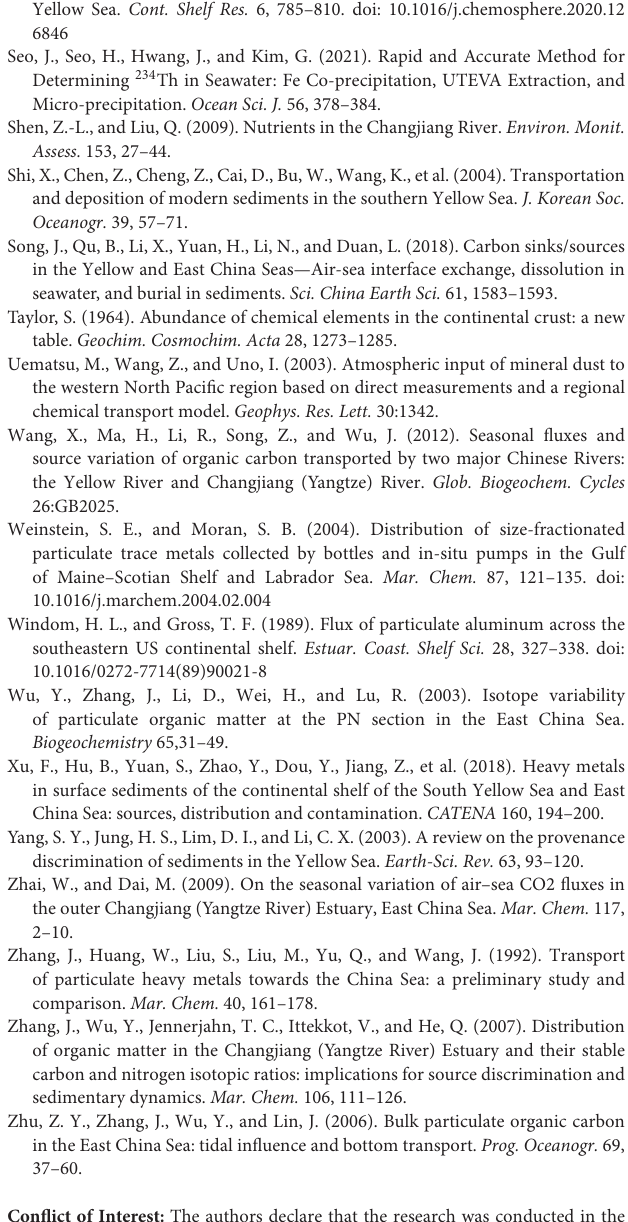
table. Geochim. Cosmochim. Acta 28, 1273–1285. Uematsu, M., Wang, Z., and Uno, I. (2003). Atmospheric input of mineral dust